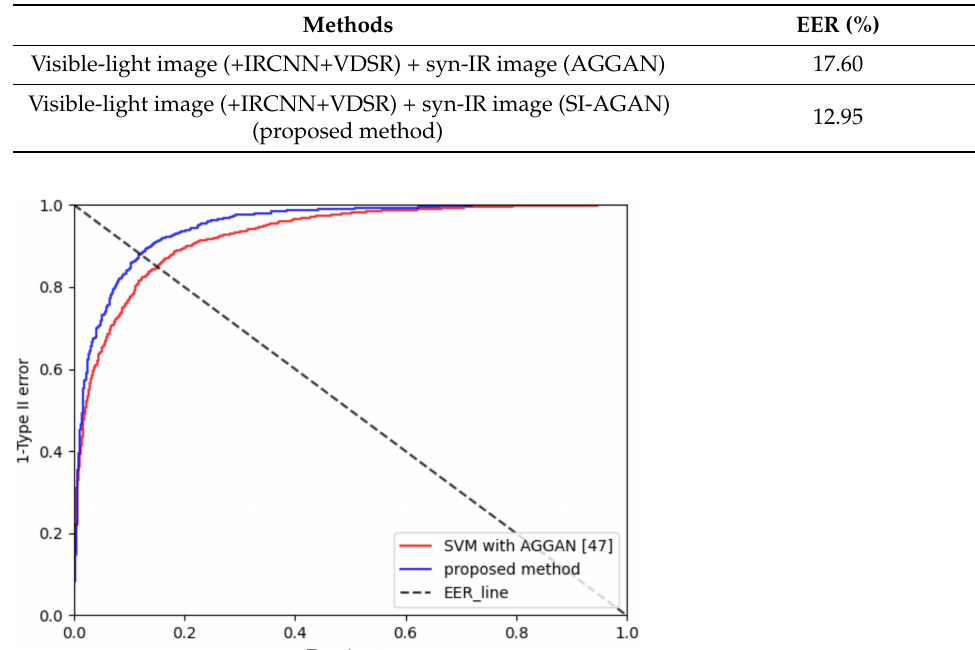
Table 15. Comparison of gender recognition accuracies based on score-level fusion.